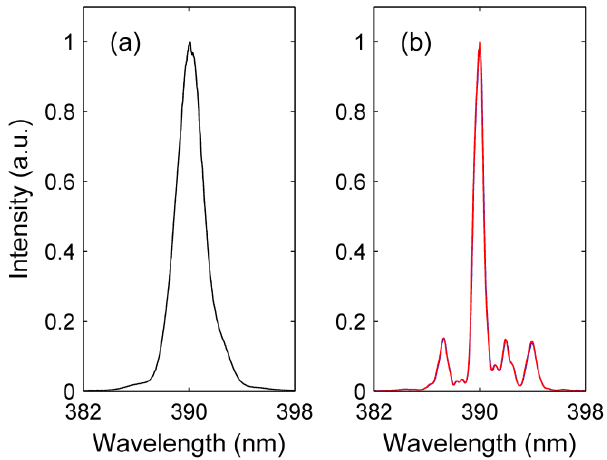
Figure 9. Spectra of autocorrelation signal ( a ) and single-beam second harmonic ( b